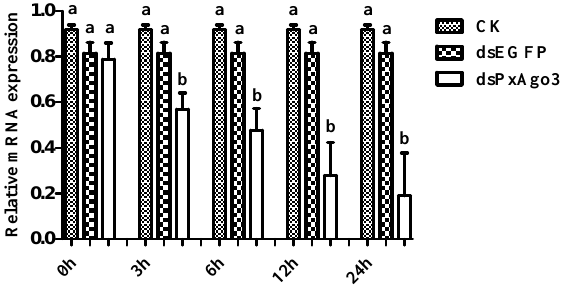
Figure 4. Comparison of PxAgo3 suppression levels in P. xylostella larvae by dsPxAgo3 at different times after treatment. Different lowercase letters represent significant differences among treatments at each time interval (Tukey’s post hoc test, p < 0.05).